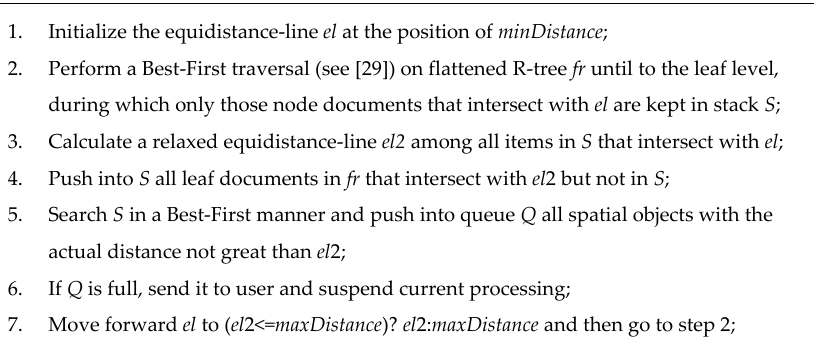
Figure 8. The distance distribution graph of an R-tree with respect to a query point.